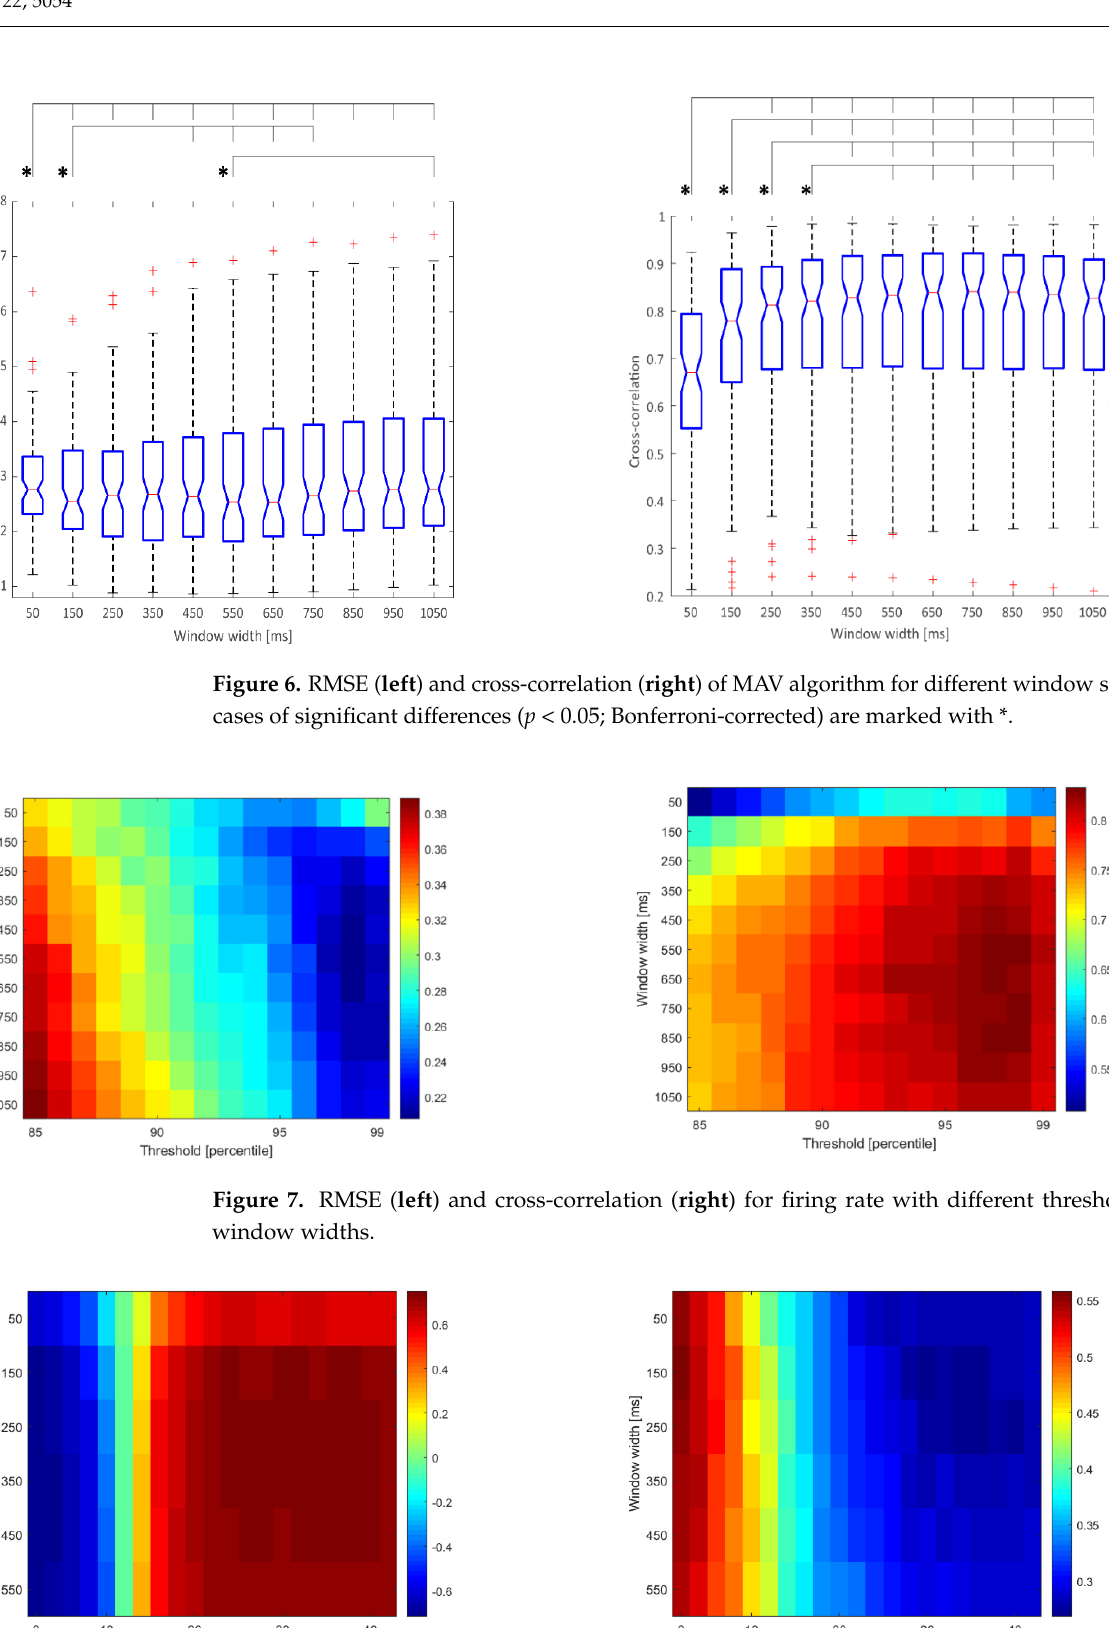
Figure 7. RMSE ( left ) and cross-correlation ( right ) for firing rate with different thresholds and win- dow widths.